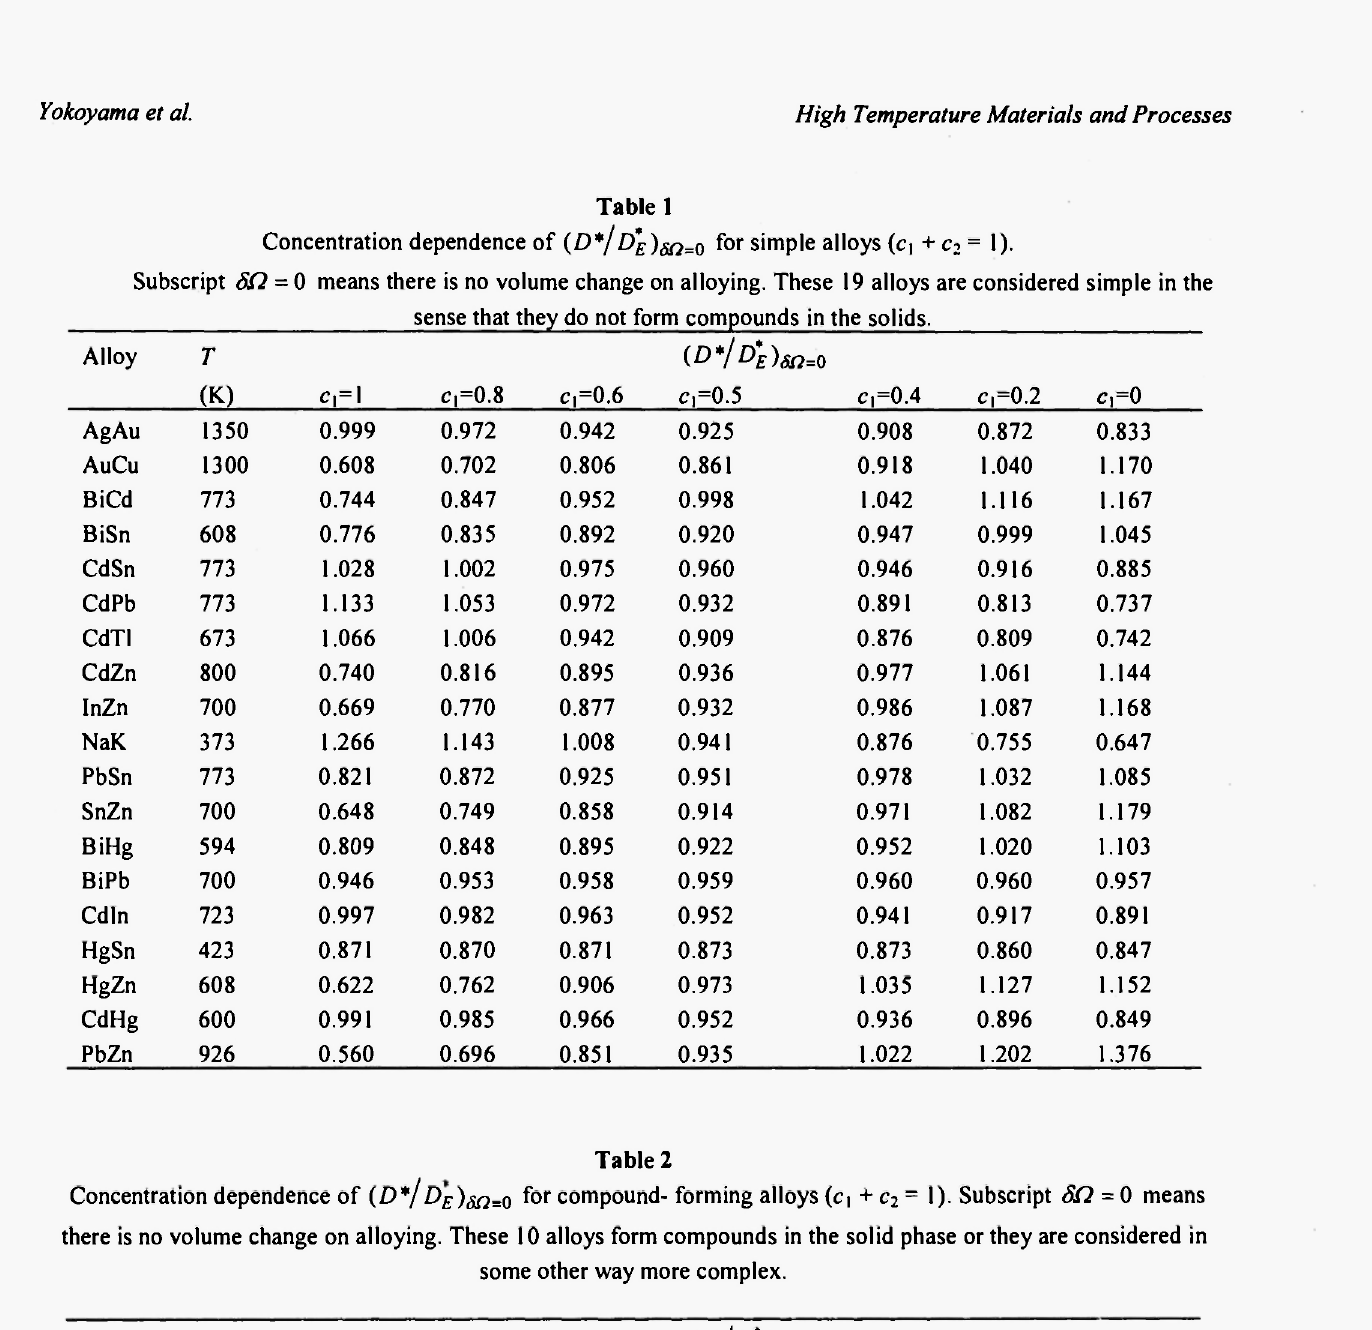
Concentration dependence of (D*/ Ω Ε )